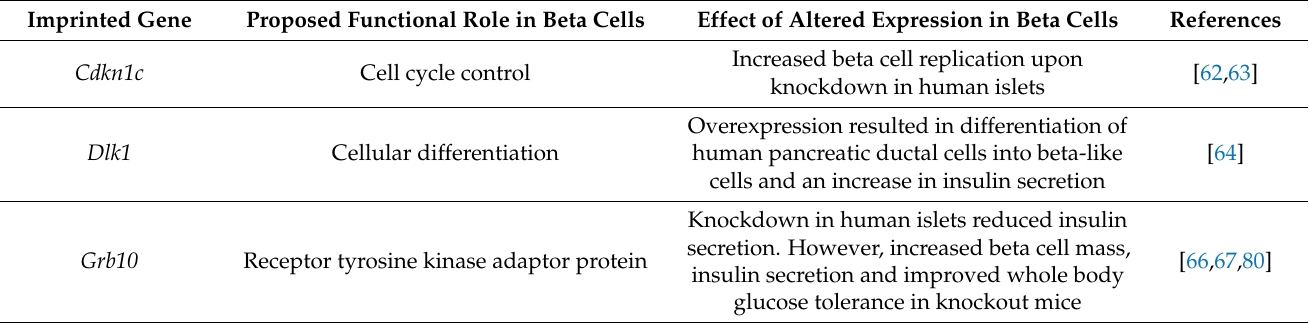
Table 1. Effect of modified imprinted gene expression on the function of mouse and human pancreatic beta cells. Imprinted Gene Proposed Functional Role in Beta Cells Effect of Altered Expression in Beta